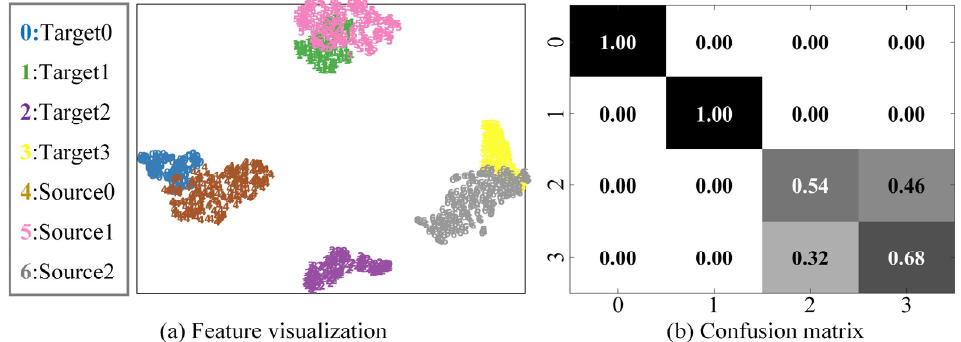
Figure 9. Results analysis of transfer task: IMS → CWRU. ( a ) Feature visualization, ( b ) Confusion matrix.